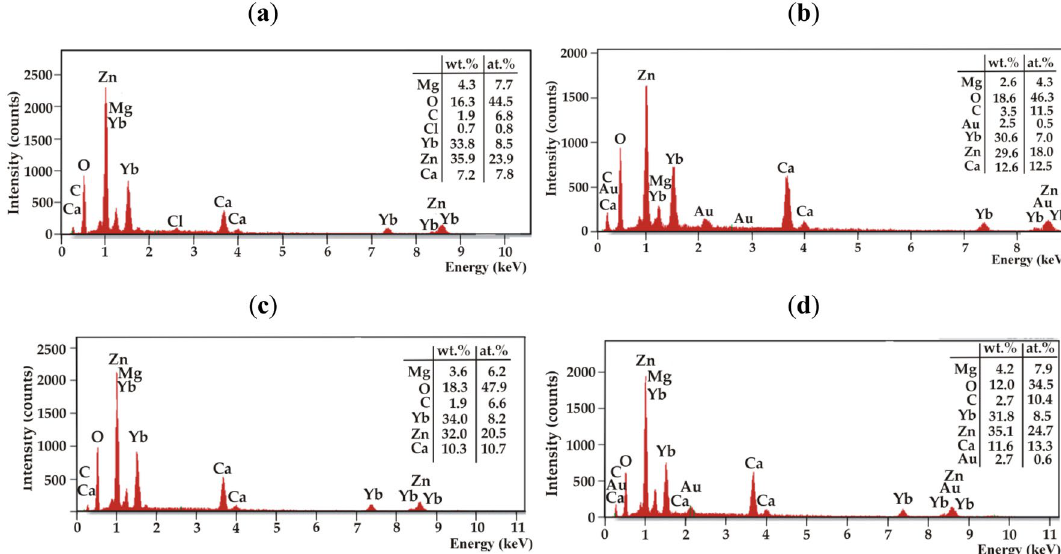
Figure 7. EDS analysis for corrosion products after 48 h of immersion in Ringer’s solution at 37 °C for: ( a ) Ca